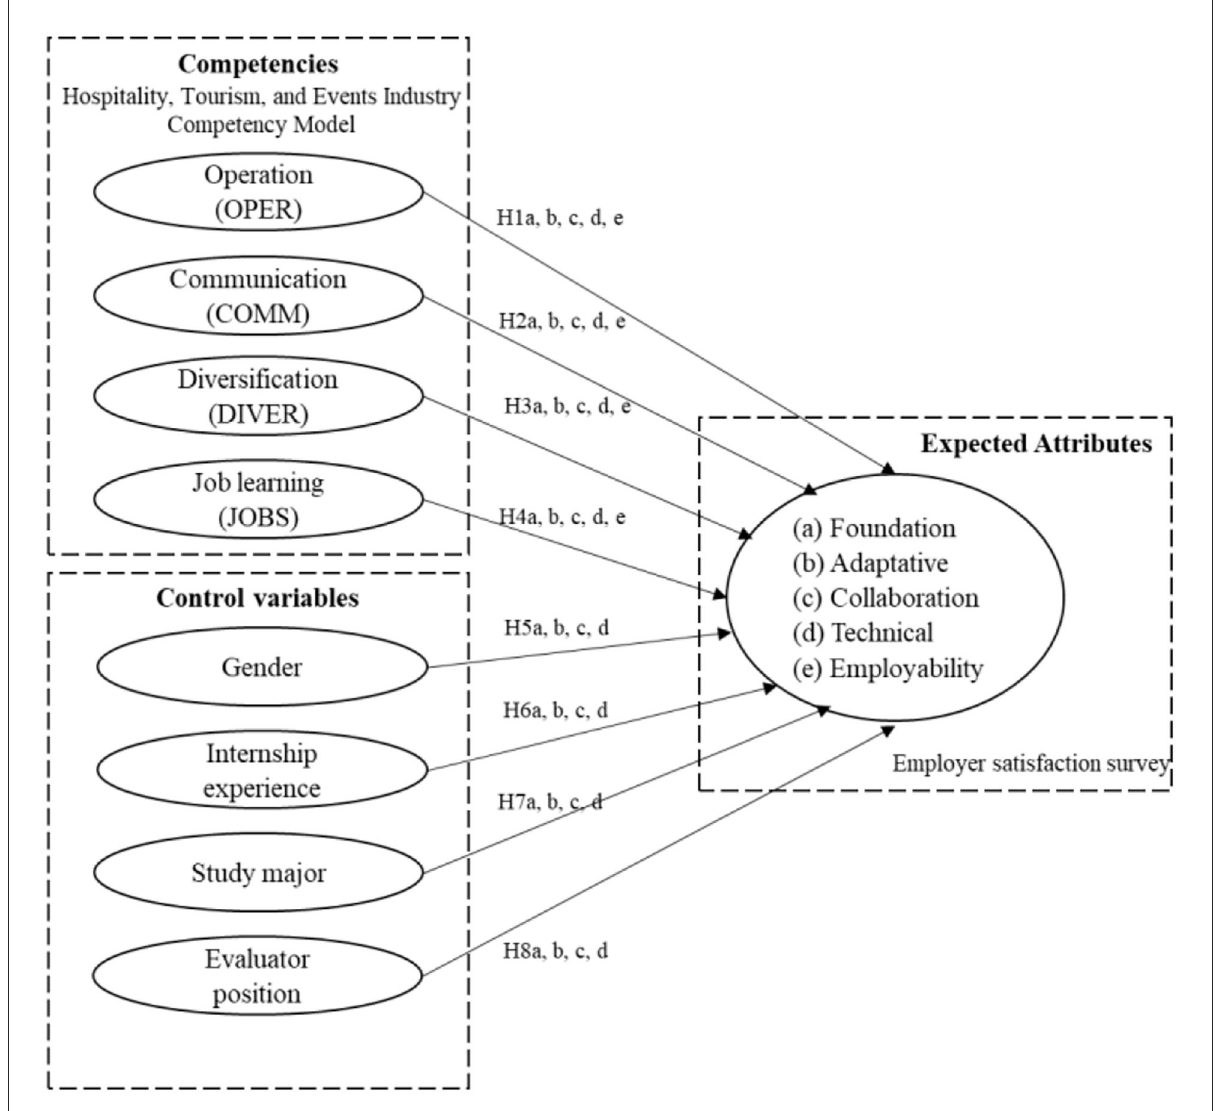
FIGURE2 The conceptual framework of the